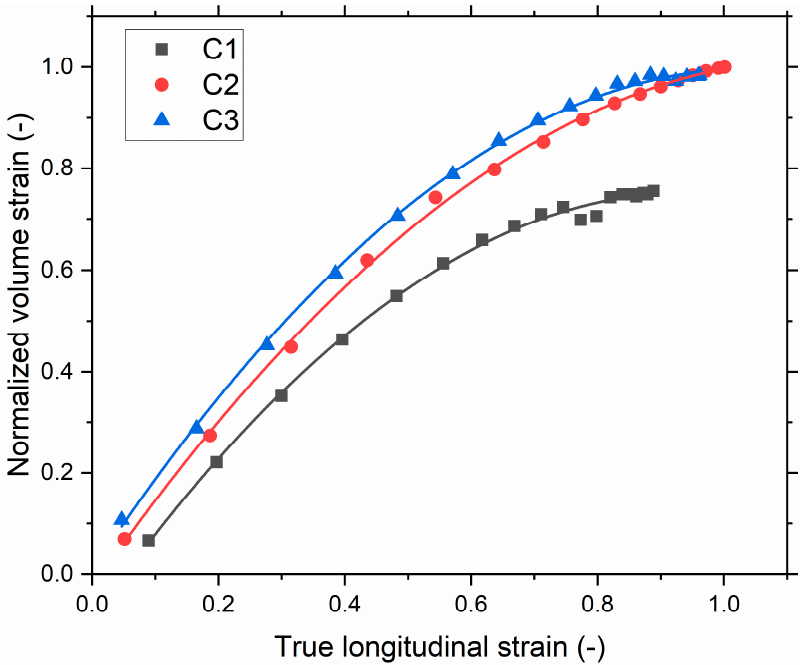
Figure 11. Normalized volume strain versus true longitudinal strain by DIC (computed for the samples being subjected to 200% of local maximum strain at the 10th loading cycle) and a polynomial fit is used.